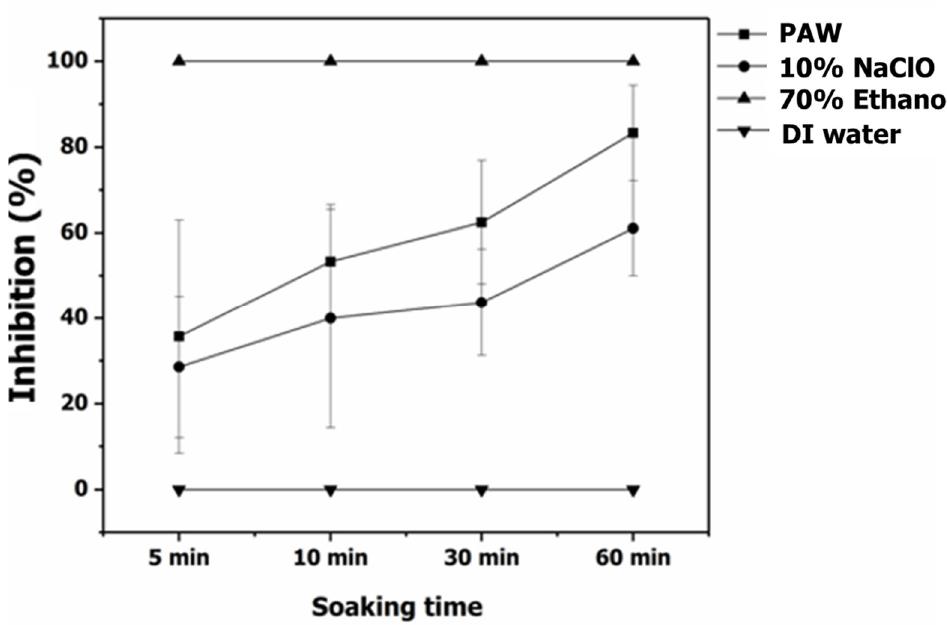
Figure 11. Disease control of Anthracnose after PAW treatments, 10% NaClO, 70% ethanol, and DI water.